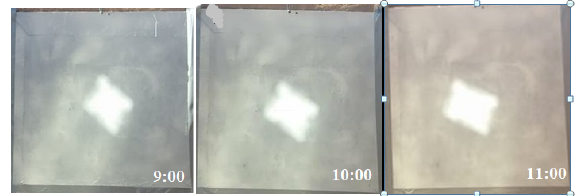
Fig. 12. Comparison between the real and